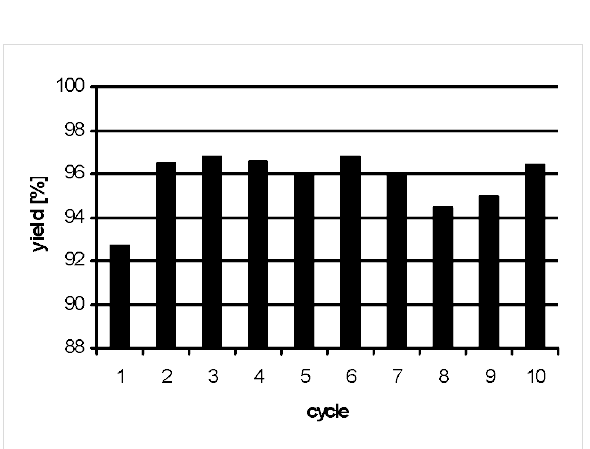
Figure 3: Repeated Heck–Mizoroki reaction of 4′-iodoacetophenone ( 23 ) with styrene ( 29 ) under flow